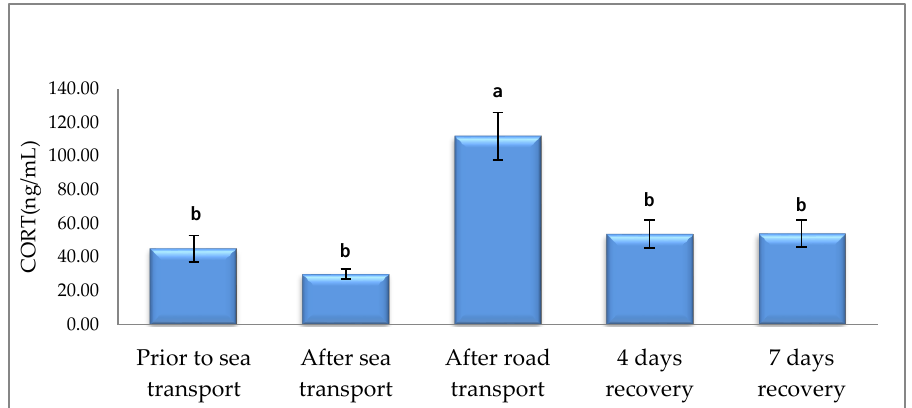
Figure 1. Effects of sea and road transport on serum cortisol concentrations in cattle. The number of animals used in each sampling point was 24 heifers. Means with different letters are significantly different at p < 0.05.